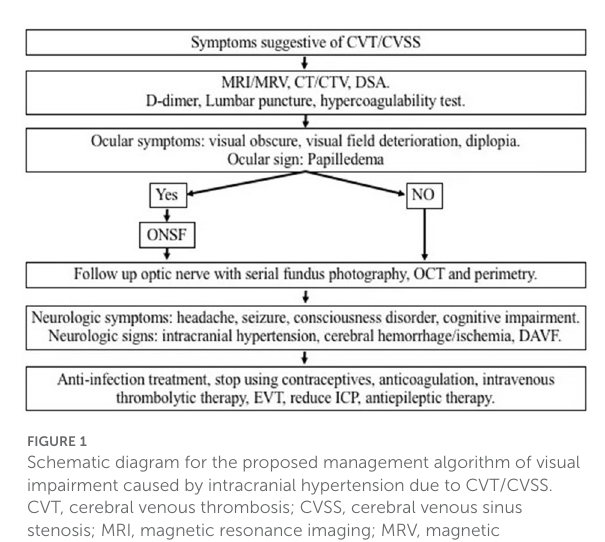
FIGURE1 Schematic diagram for the proposed management algorithm of visual impairment caused by intracranial hypertension due to CVT/CVSS. CVT, cerebral venous thrombosis; CVSS, cerebral venous sinus stenosis; MRI, magnetic resonance imaging; MRV, magnetic resonance venography; CT, computed tomography; CTA, computed tomographic angiography; ONSF, optic nerve sheath fenestration; OCT, optical coherence tomography; DAVF, dural arteriovenous fistula; EVT, endovascular therapy; ICP, intracranial